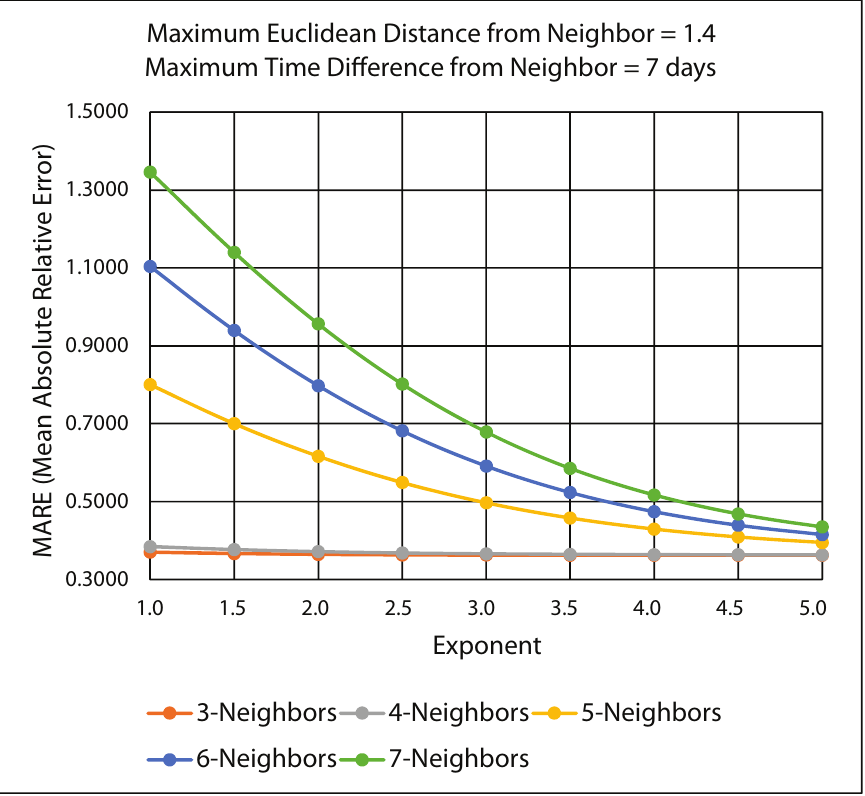
Figure 18. MARE LOOCV results for the various 45 IDW methods using the improved IDW